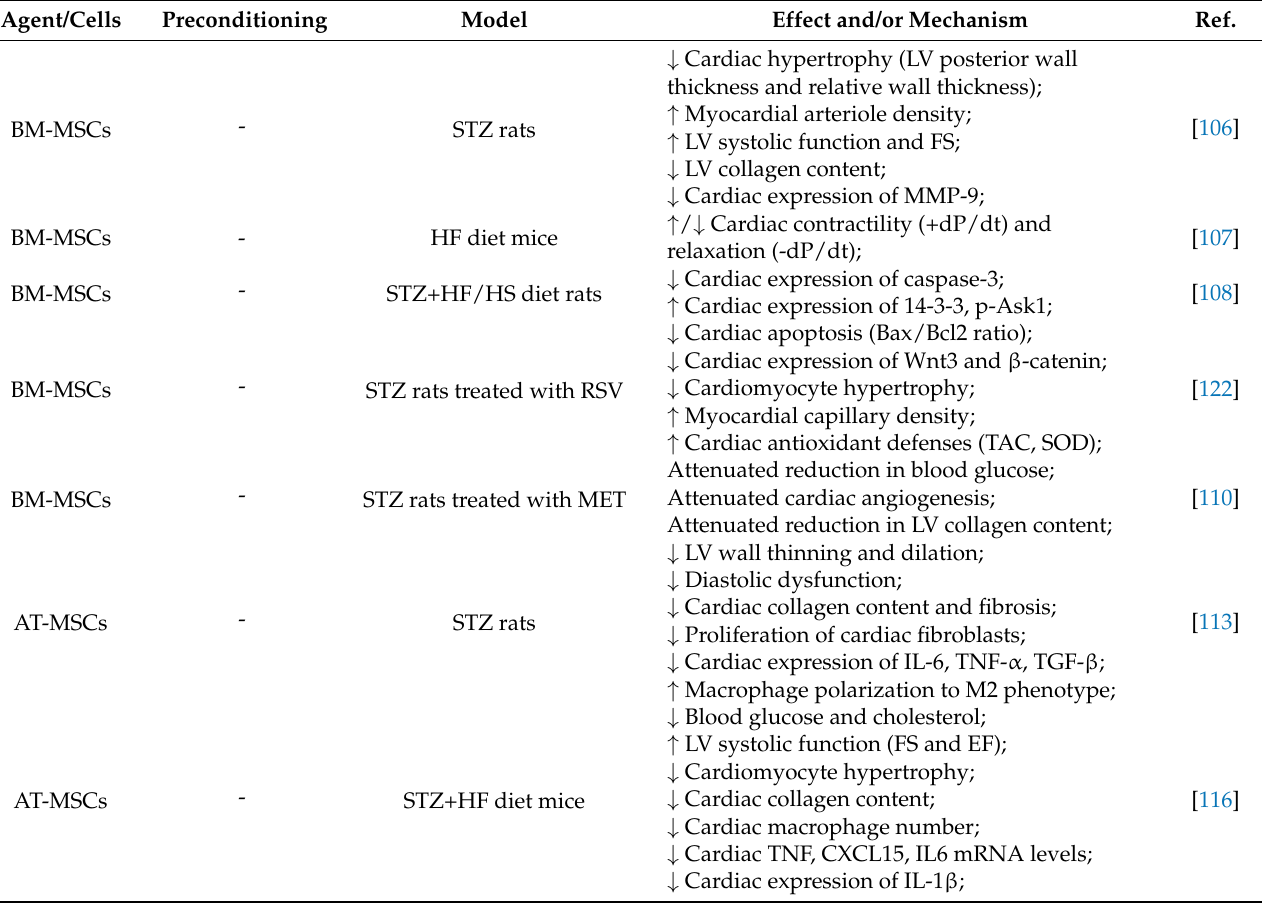
Table 1. Summary of findings from preclinical